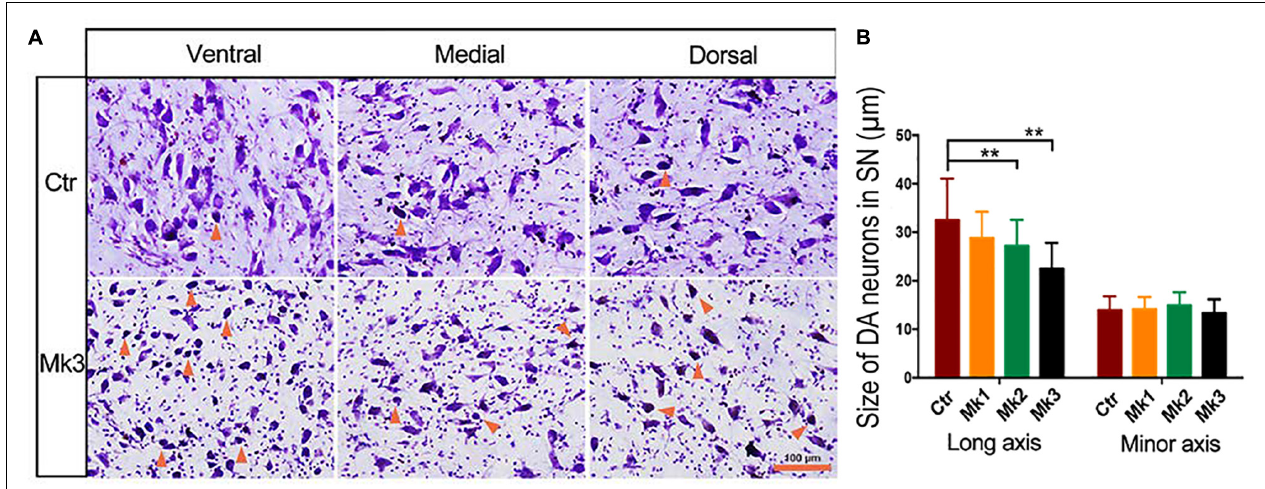
FIGURE 2 | Photomicrographs of Nissl staining in the SNc in a control and in a MPTP-injected monkey. (A) The micrograph of Nissl staining in control and in monkey 3 (Mk3) that displayed the most severe structural and functional deficits. The images were taken from ventral, medial, and dorsal areas of the substantia nigra (SN) for both monkeys. Note that in control monkeys, only a few atrophic neurons (with darker color and smaller soma size than normal neurons, arrows) were seen. In addition, neurites can be clearly observed. In Mk3, however, more atrophic neurons can be discerned, and the neurites were less abundant than the control, especially in ventral SN. (B) Quantification of the size of Nissl -stained neurons in control and in three MPTP-injected monkeys, Mk1, Mk2, and Mk3. The value of control represents the average of three control monkeys. Note the significant decrease of the size of Nissl -stained neurons in Mk2 [ F (3,122) = 8.607, P < 0.0001] and Mk3 [ F (3,141) = 5.579, P = 0.0012] compared to control, when measurement was based on long axis, but not when based on minor axis. ANOVA, ∗∗ P < 0.01 and